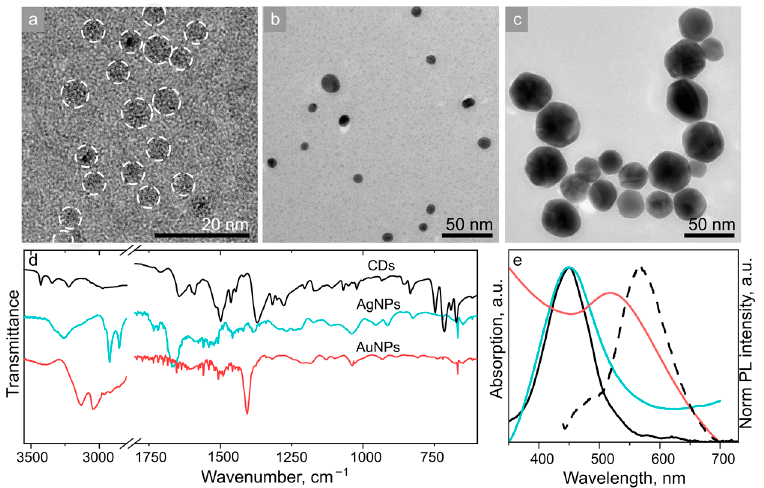
Figure 3. TEM images of ( a ) CD-3, ( b ) AgNPs, and ( c ) AuNPs. ( d ) FTIR and ( e ) absorption spectra of CD-3 (black), AgNPs (cyan), and AuNPs (red). PL spectrum of CD-3 excited at 405 nm is also shown on the frame ( e ) by a black dashed line.